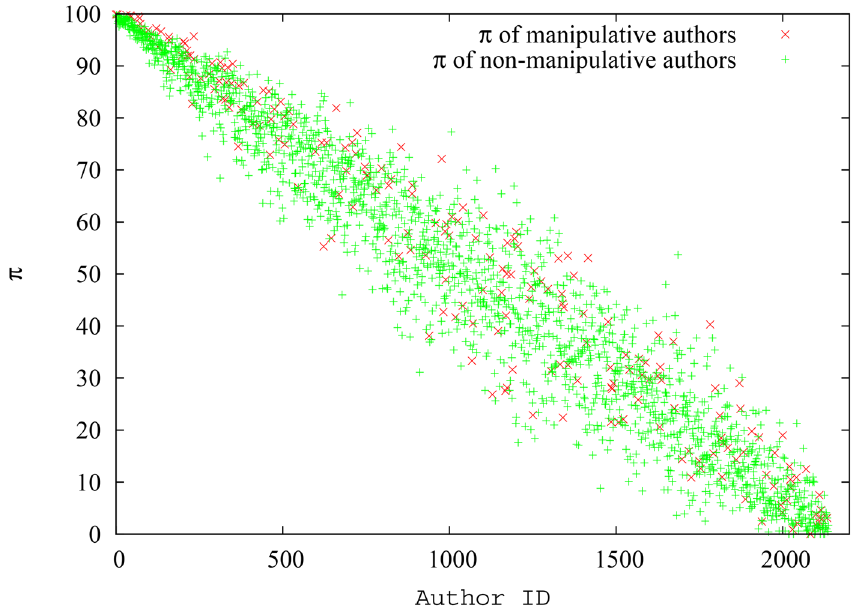
Fig 4. Spread of the pagerank-index for each manipulative and non-manipulative author (as absolute values) in the first simulation scenario. Neither group of authors have a clear advantage here.